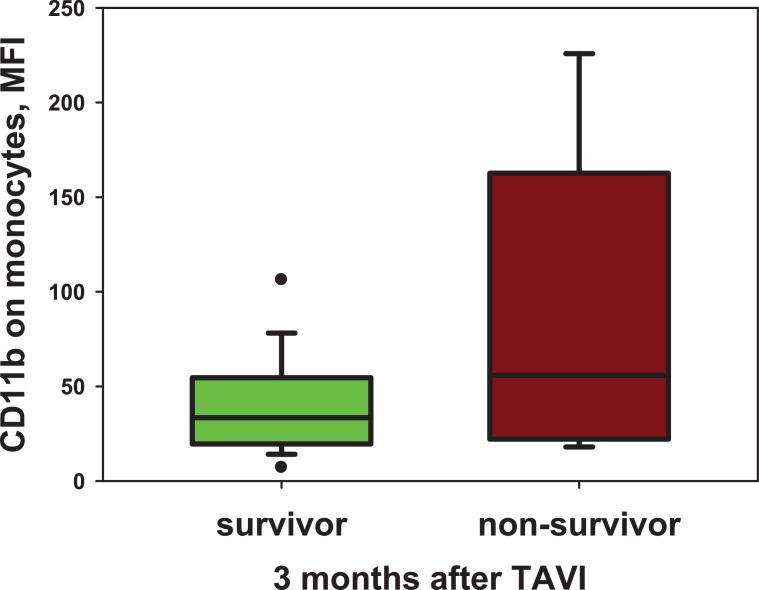
The CD11b-expression on monocytes in dependence of three-month survival after TAVIThe mean fluorescence intensity (MFI) of CD11b on monocytes before TAVI in comparison of survivor (n=105) with non-survivor (n=15) three months after TAVI. Data are presented as box and whisker plots. The ends of the whiskers represent the 5th and the 95th percentile. p=0.024